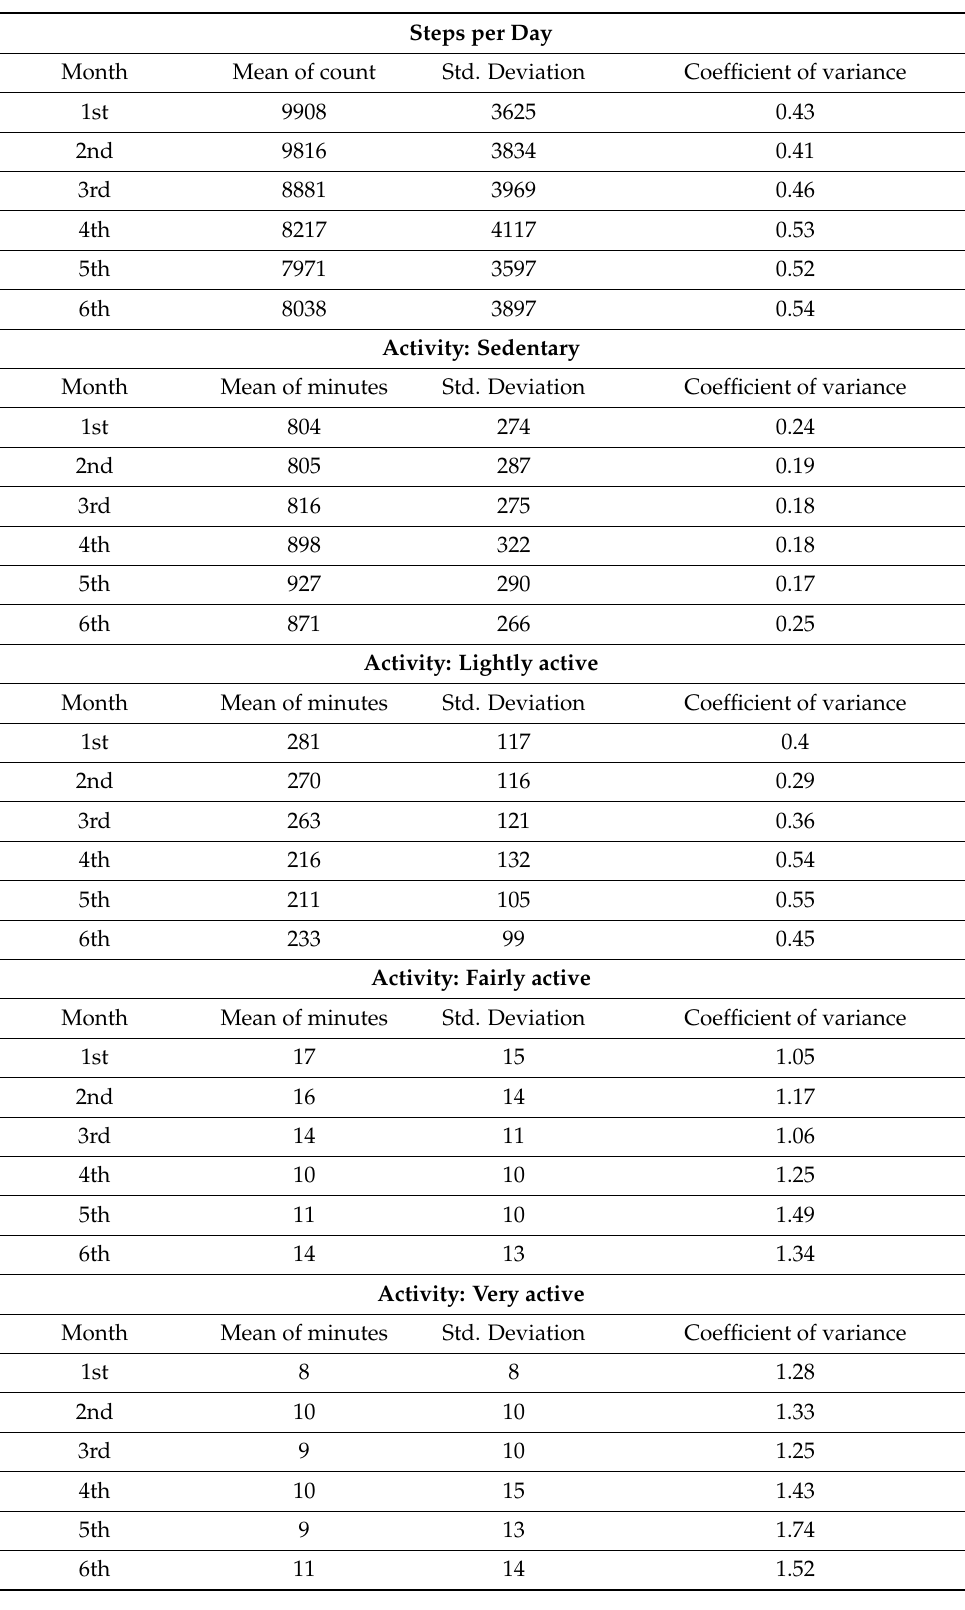
Table 3. Data from Fitbit Inspire physical activity